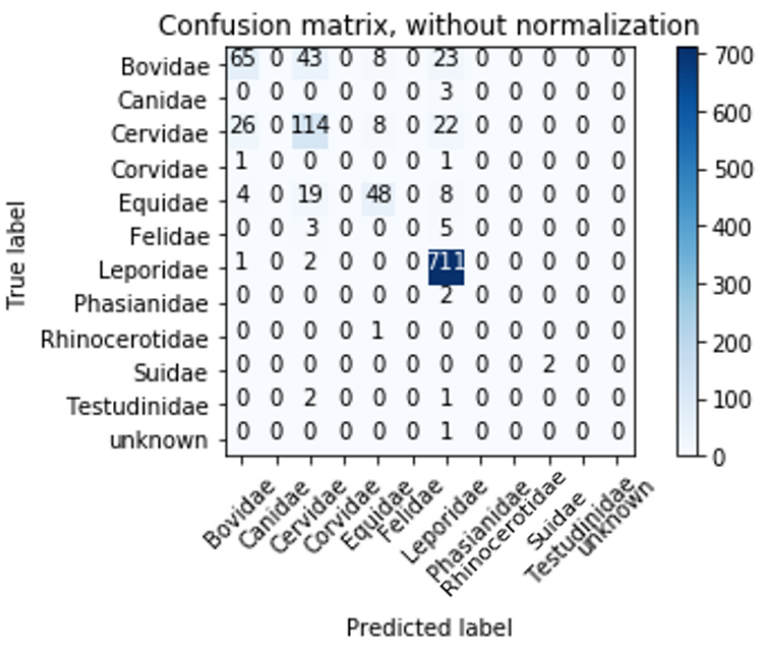
Figure 5. Confusion matrix of the medium